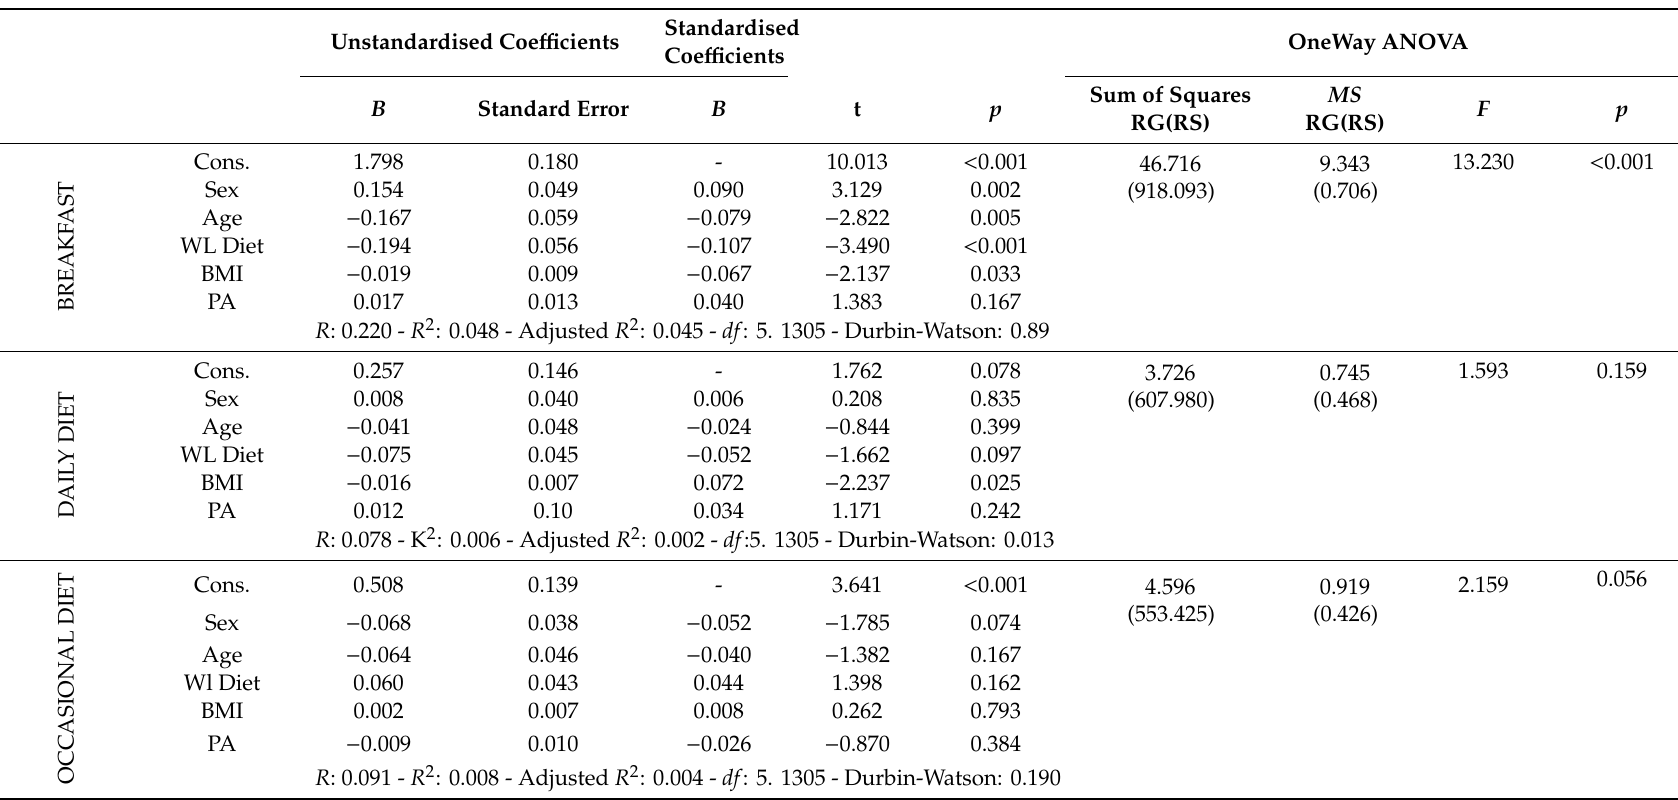
Table 3. Regression analysis: quality of breakfast, occasional healthy diet and daily healthy diet (dependent variables) and weight loss diet adherence, body mass index and level of practice of physical activity (independent variables), adjusted to co-variables of sex and age. Standardised Unstandardised Coe ffi cients Coe ffi